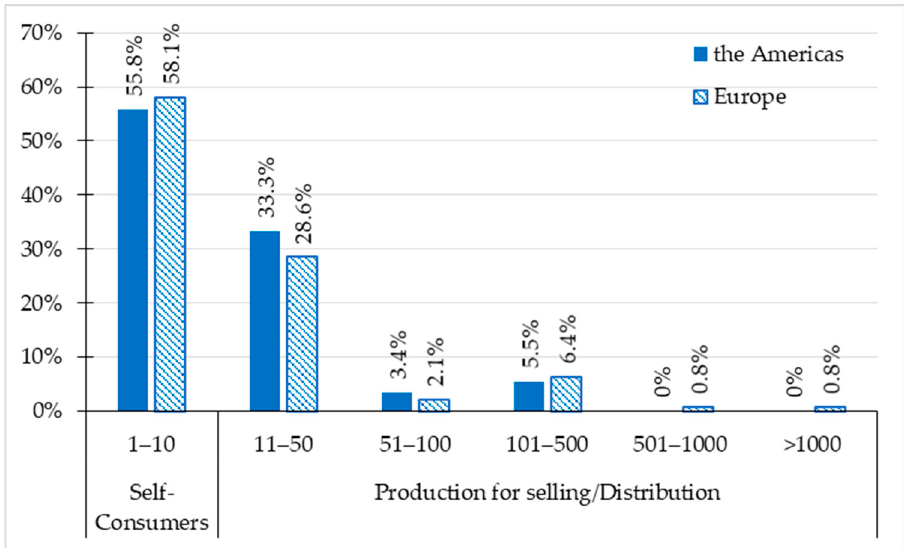
Figure 1. Amount of colonies managed by respondent beekeepers both in the Americas and in Europe. Gathered in two categories, “self-consumers” consisted of beekeepers who produced hive products for themselves and “production for selling/distribution” the beekeepers that sell products.